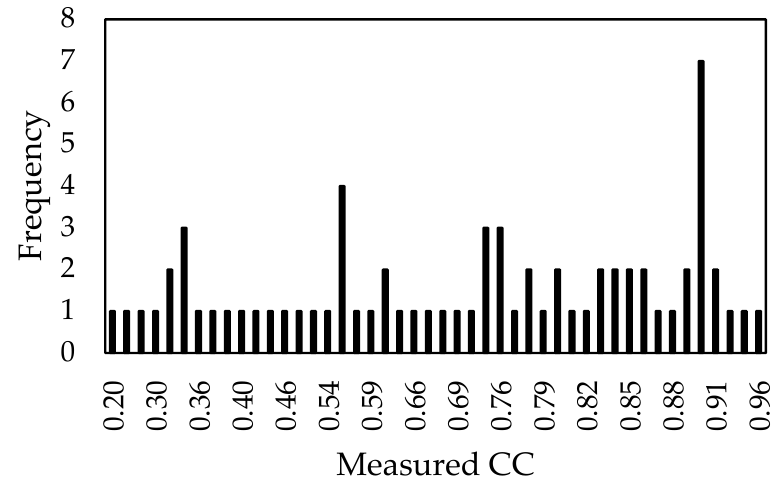
Figure 2. Measured CC frequency distribution diagram.